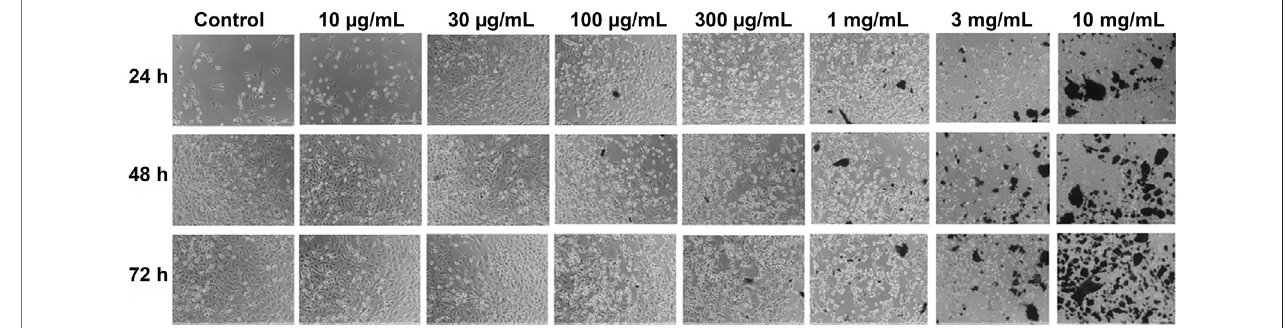
FIGURE1| Representativephase-contrast imagesoftheovariancancercellline(SKOV3)followingtreatmentwithkhatextractsatdifferentconcentrations(10,30, 100, 300 μ g/ml, 1, 3, 10 mg/ml) and different time points (24, 48, and 72 h). Compared to control, the SKOV3 cells exposed to khat extracts demonstrated cell growth inhibition and death with increasing concentration of the extract. Magni fi cation 10x.